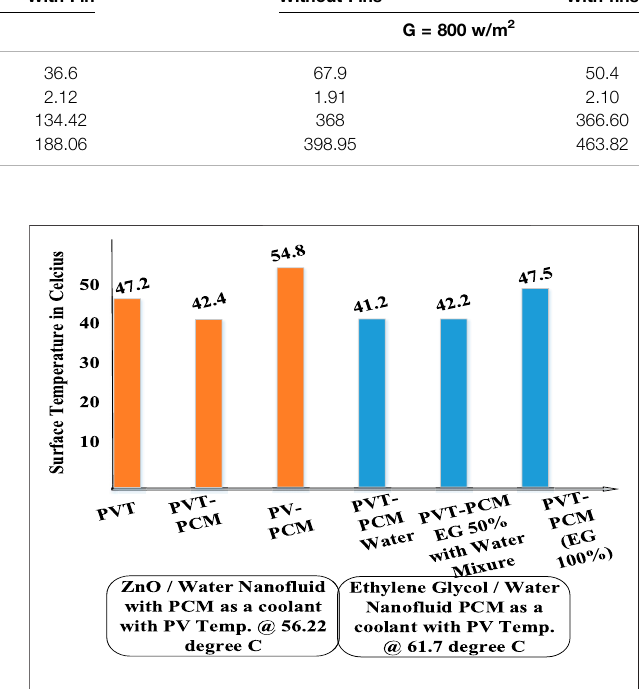
TABLE 5 | Voltage and current values with and without the contribution of fi ns. Parameters Without Fin